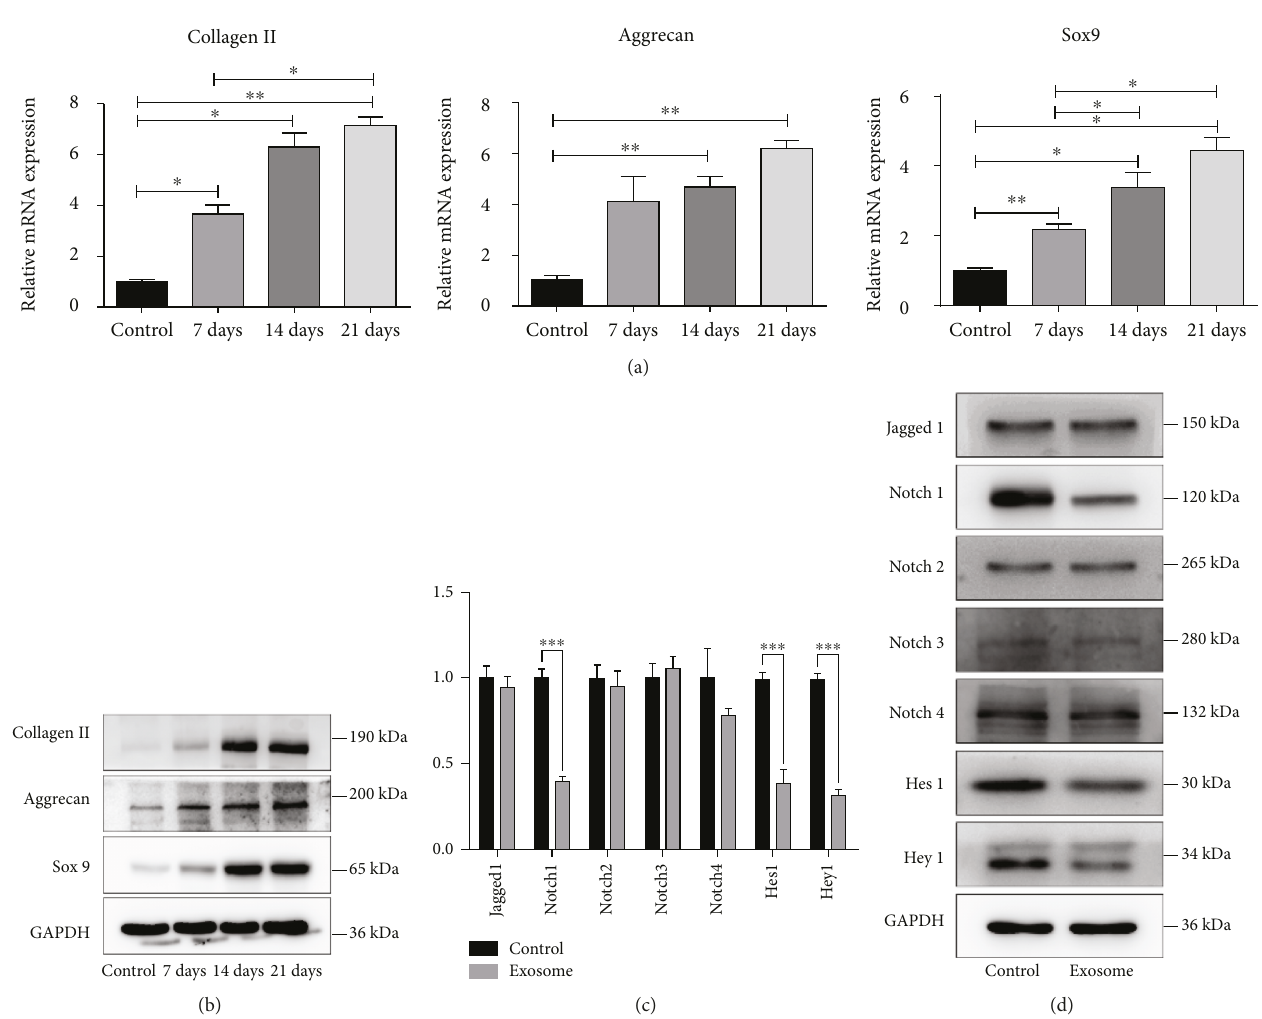
Figure 3: Expression of NPC markers and Notch pathway in NPC exosome-treated MSCs. (a) Gene expression of NPC markers (collagen II, Aggrecan, and Sox9) was signi fi cantly upregulated in exosome-treated MSCs in 7, 14, and 21 days. (b) Expression of related protein was normalized to GAPDH. (c) Expression of Notch pathway-related genes in exosome-treated MSCs was detected by qRT-PCR. (d) Western blot analysis of Notch pathway-related protein in exosome-treated MSCs. All data were showed as mean ± SD . N = 3 . ∗ P < 0 05 , ∗∗ P < 0 01 , and ∗∗∗ P < 0 001